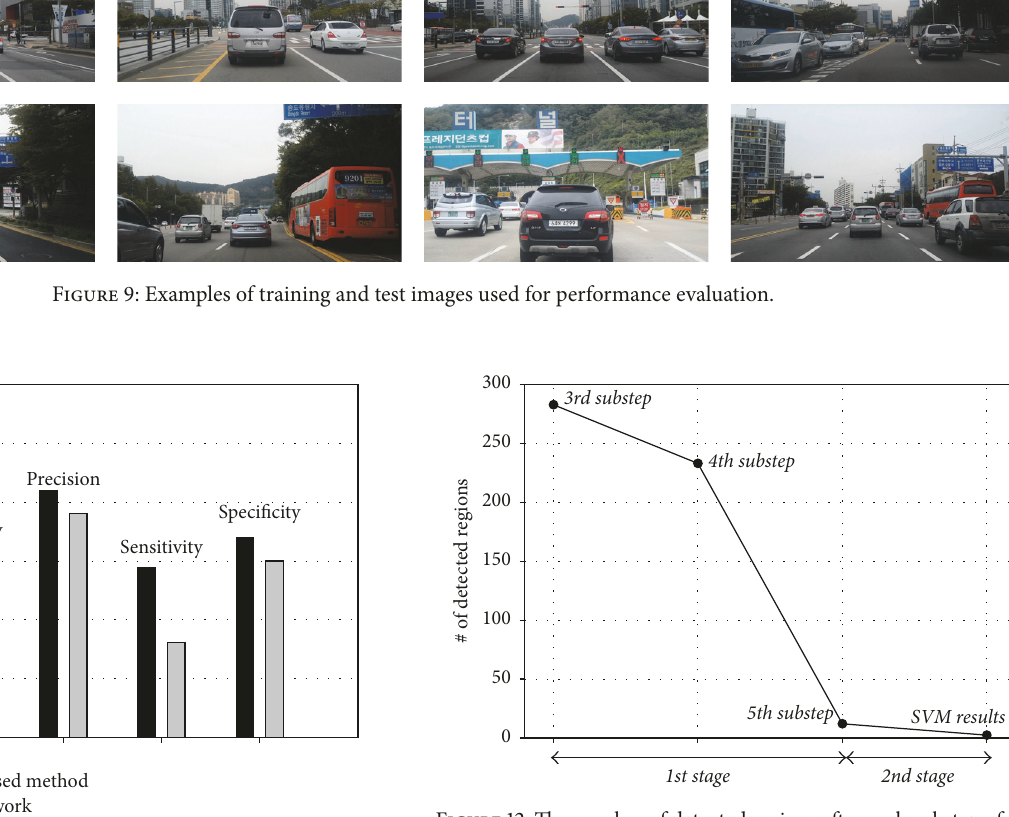
Figure 12: The number of detected regions after each substep of the first